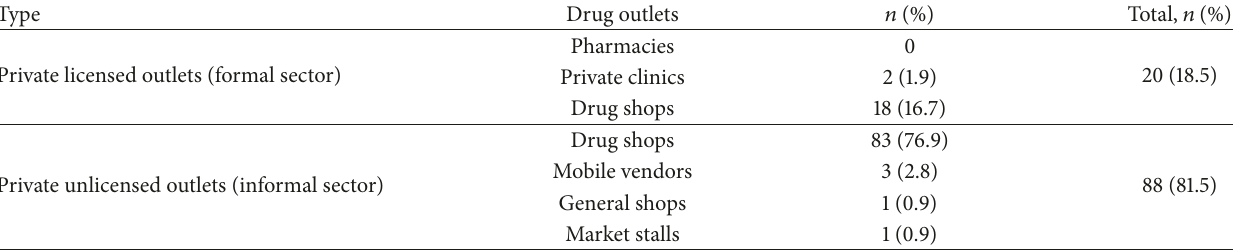
Table 1: Distribution of private-for-profit drug outlets at study site parishes across Butaleja (𝑛 = 108)